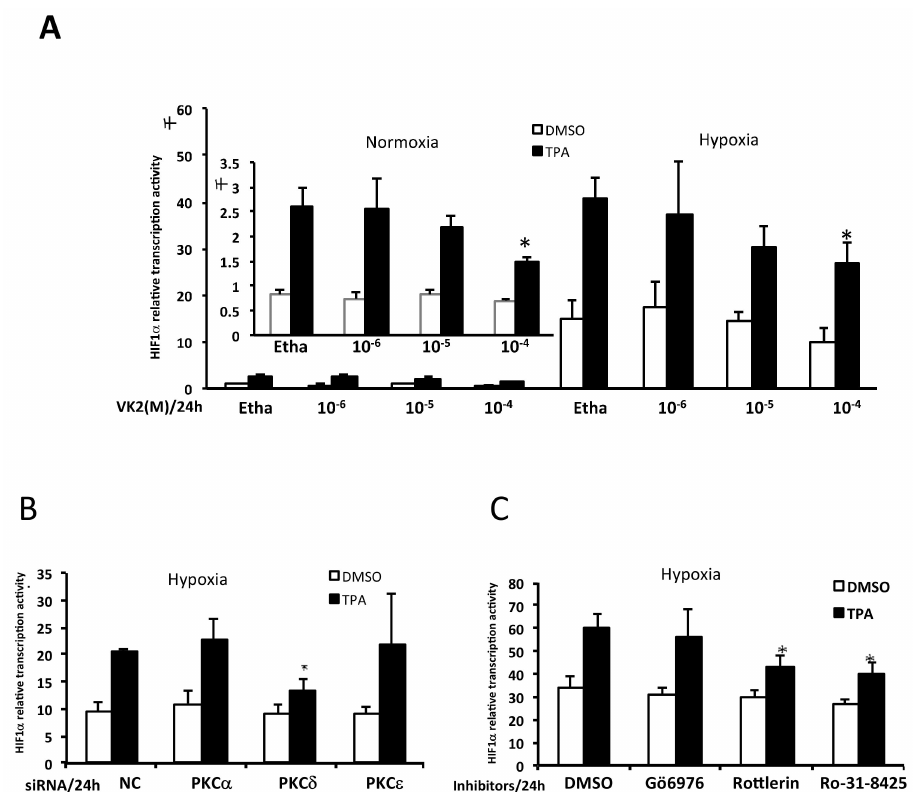
Figure 1. VK2 inhibited TPA-induced HIF-1 α -driven luciferase expression, and PKC- δ is involved in the activation of HIF-1 α transcription under both normoxic and hypoxic conditions in Huh7 cells. ( A ) The effects of VK2 on the HIF-1 α -driven luciferase assay under normoxic (left and shown in enlarged panel) and hypoxic (right) conditions ( n = 5). Hypoxia upregulated the HIF-1 α luciferase activity more than 10-fold, and TPA increased the luciferase activity 3- to 4-fold both under normoxic and hypoxic conditions. VK2 dose-dependently suppressed the TPA-induced HIF-1 α luciferase activity under both conditions. ( B ) The effects of PKC isoform knockdown by specific siRNAs on the HIF-1 α transcriptional activity ( n = 5). Knockdown of PKC- δ inhibited the TPA-induced HIF-1a luciferase activity under hypoxic conditions, whereas that of PKC- α or PKC- ε showed no marked effects. Without TPA, no significant changes were induced by any PKC isoform siRNAs. ( C ) The effects of PKC inhibitors on the HIF-1 α transcriptional activity ( n = 5). The PKC- δ inhibitor rottlerin (10 nM) significantly inhibited the TPA-induced HIF-1 α luciferase activity to the same degree as the pan-PKC inhibitor Ro-31-8425 (100 nM). The PKC- α inhibitor Gö6976 (10 nM) did not show any suppressive effects. Data were obtained from at least three independent experiments. Bars, standard deviation; * P < 0.05 (Student (cid:48) s t -test). Etha, Ethanol; NC, negative control